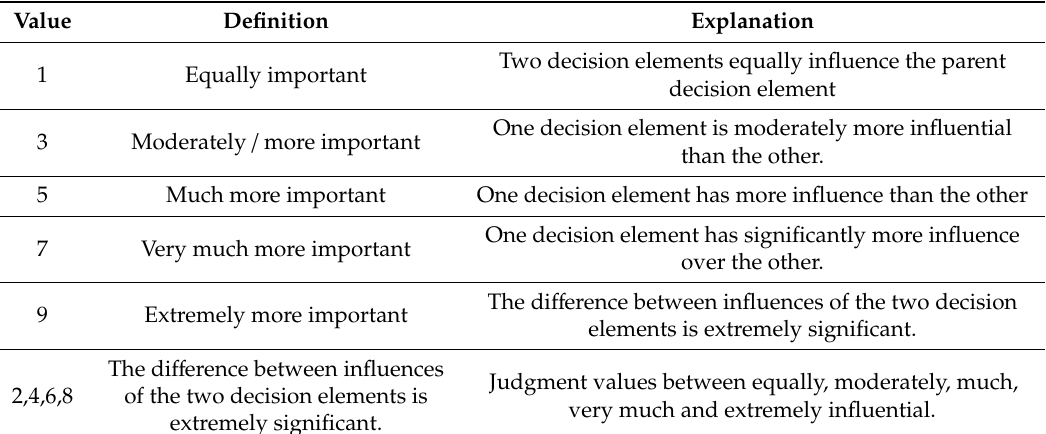
Table 1. Saaty’s fundamental scale (Saaty, 1980).